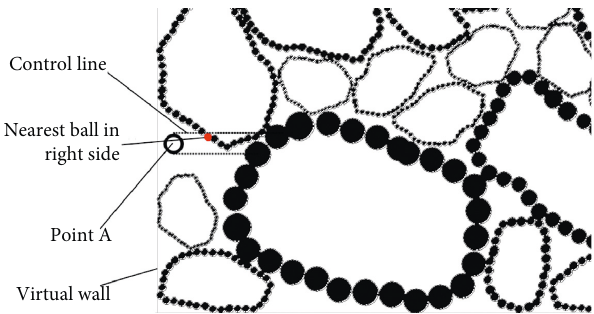
Figure 6: Distinguishing the position of mastic balls between the particle clump and the wall on the left side.